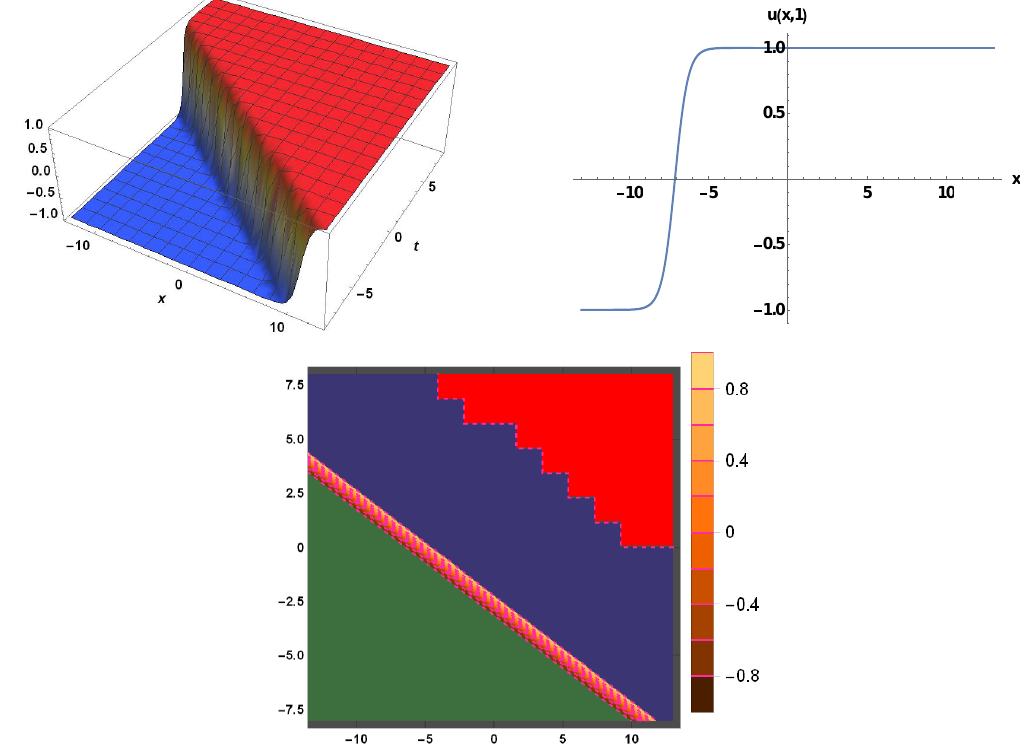
Figure 3. The solitary wave view of the 3D, 2D, and contour plots of U 3 ( x , t ).